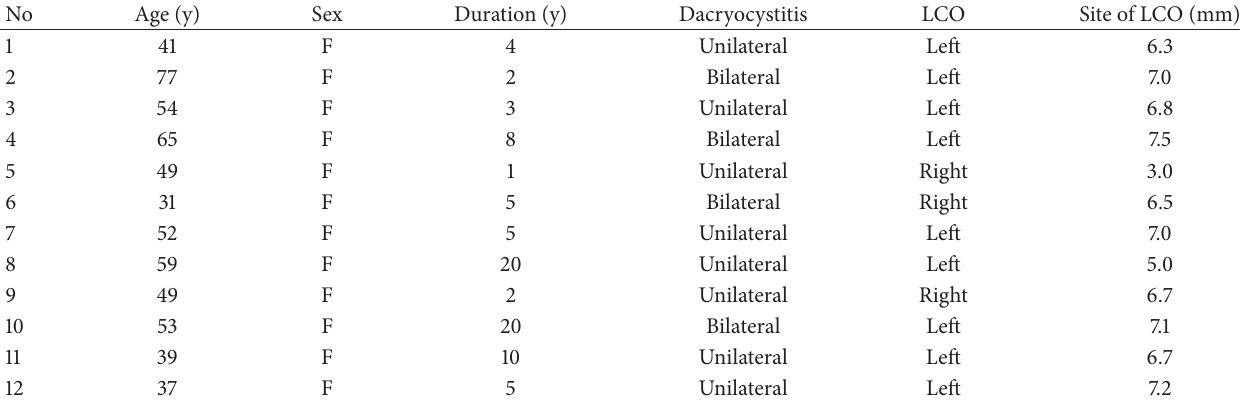
Table 1: The information of 12 patients with dacryocystitis and canalicular obstruction.